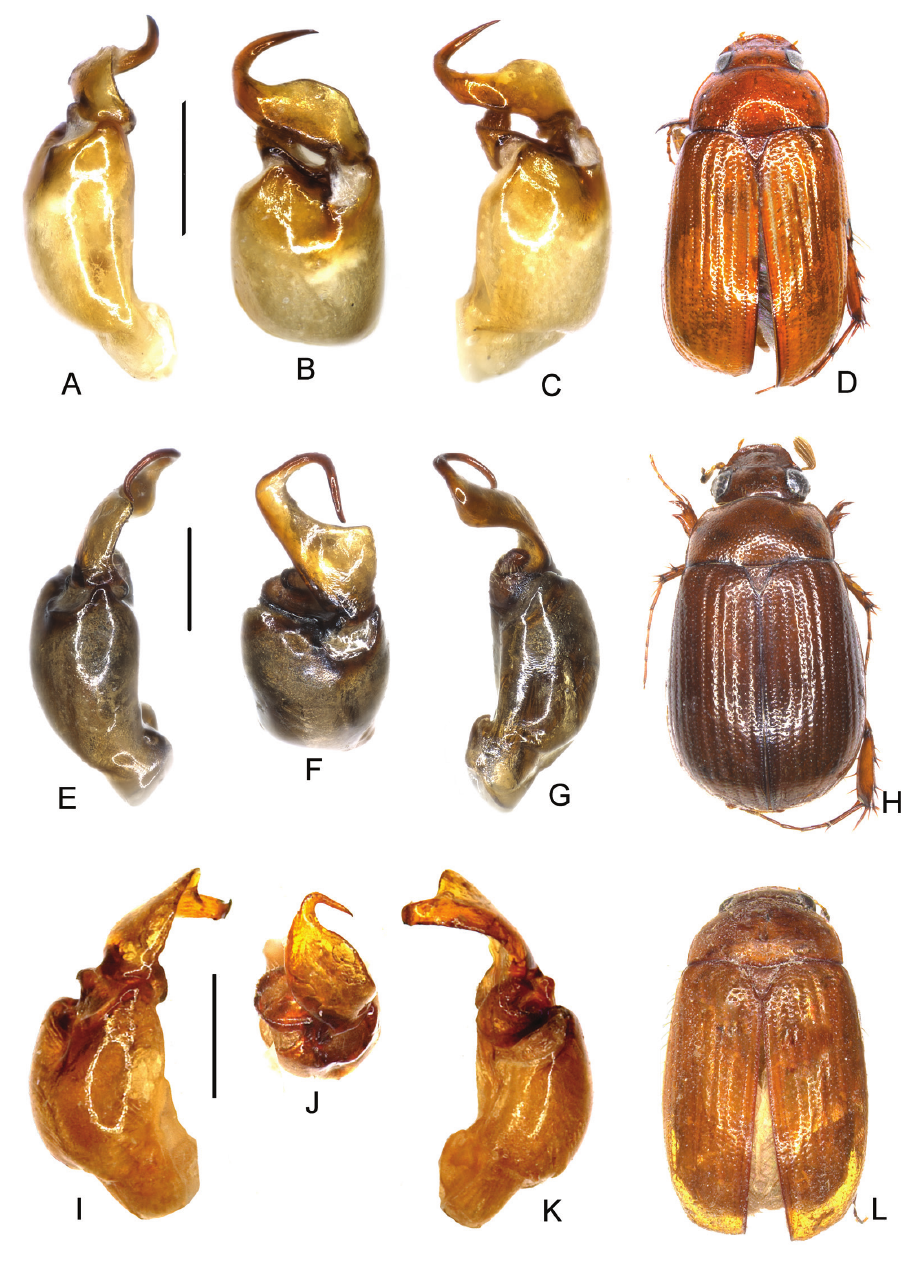
Figure 1. A–D Neoserica fugongensis Ahrens, Fabrizi & Liu, sp. n. (holotype) E–H N. mantillieri Ah- rens, Fabrizi & Liu, sp. n. (holotype) I–L N. dongjiafenensis Ahrens, Fabrizi & Liu, sp. n. (holotype) A, E aedeagus, left side lateral view C, G aedeagus, right side lateral view B, F parameres, dorsal view D, H habitus. Scale bars: 0.5 mm. Habitus not to